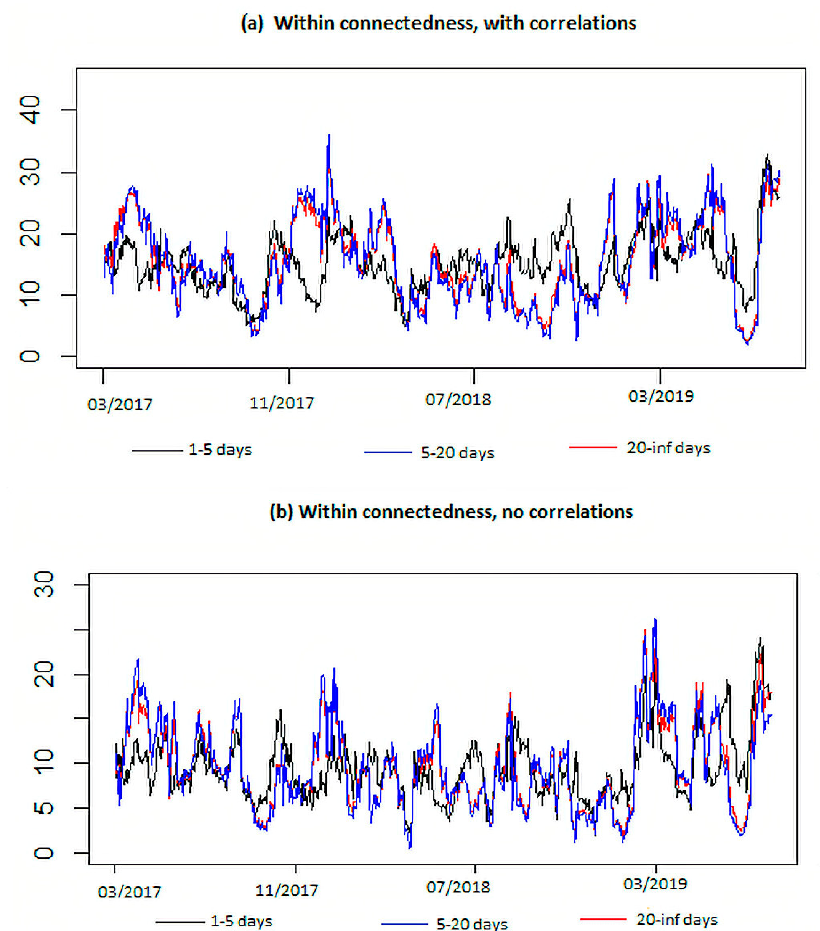
Figure 8. Within scale connectedness between bitcoin, gold, and crude oil return returns. Note: Within connectedness by Barun í k and Kˇrehl í k (2018). Plot ( a ) represents the relative connectedness within the frequency band with [1; 5] days in black, [5; 20] days in blue, and [20; 300] days in red. Plot ( b ) presents the relative connectedness within the frequency band without the e ff ect of cross-sectional